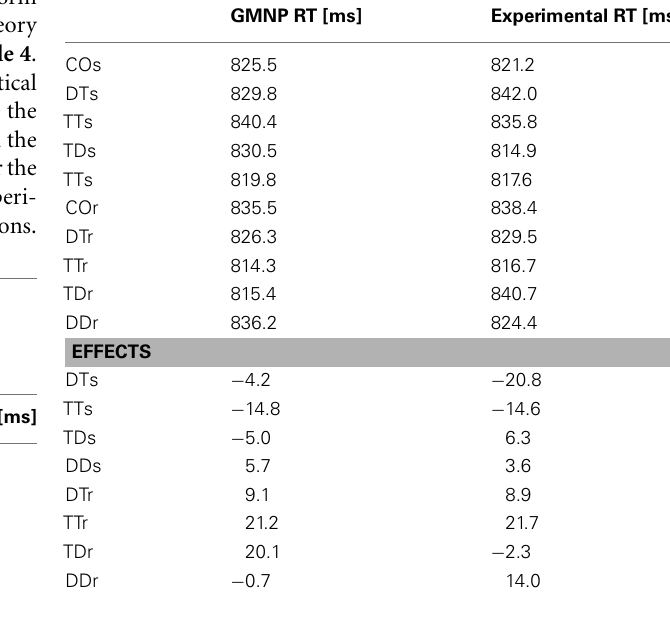
Table 7 | Simulated reaction times and effects by the GMNP in distractor inhibition mode compared to experimental results from Ihrke et al. (2011), after fitting model parameters to minimize the RMSE in control RT and the effect sizes forTT and DT